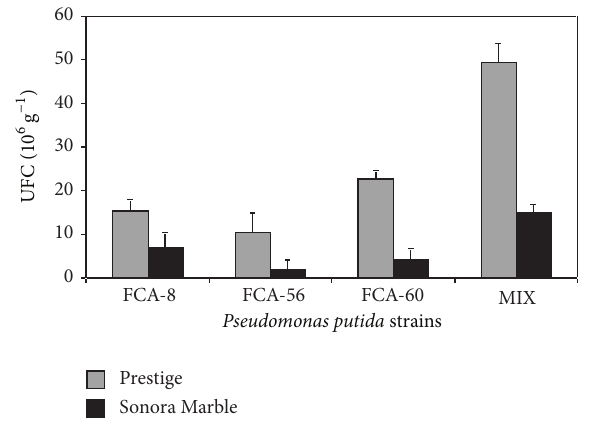
Figure 1: Population of Pseudomonas putida strains in the rhizo- sphere of poinsettia Prestige and Sonora Marble cultivars. Colony forming units (CFU) in plants with P. putida strain: FCA-8, FCA- 56, FCA-60, and MIX (inoculated simultaneously with the three rhizobacteria) at 110 DAI. Data for controls of both Prestige and SonoraMarblecultivarsarenotshownsincetheywerefoundtohave 0